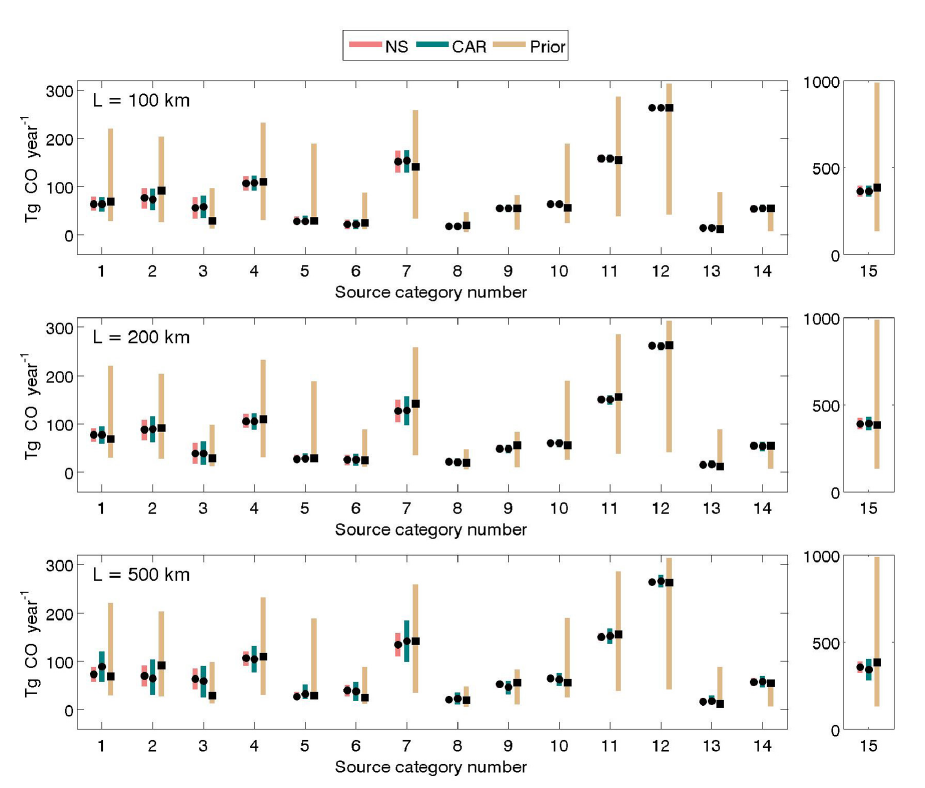
Fig. 7. Plots of 95% posterior credible intervals for NS and CAR model analyses for L = 100, 200 and 500km, showing summary inferences of source magnitude for all 15 CO source categories for one synthetic dataset (see Fig. 2 for definition of source category numbers). Posterior means for both are marked with dots inside the corresponding intervals. Alongside we plot 95% prior credible intervals for the corresponding source and indicate the “true” CO source with a